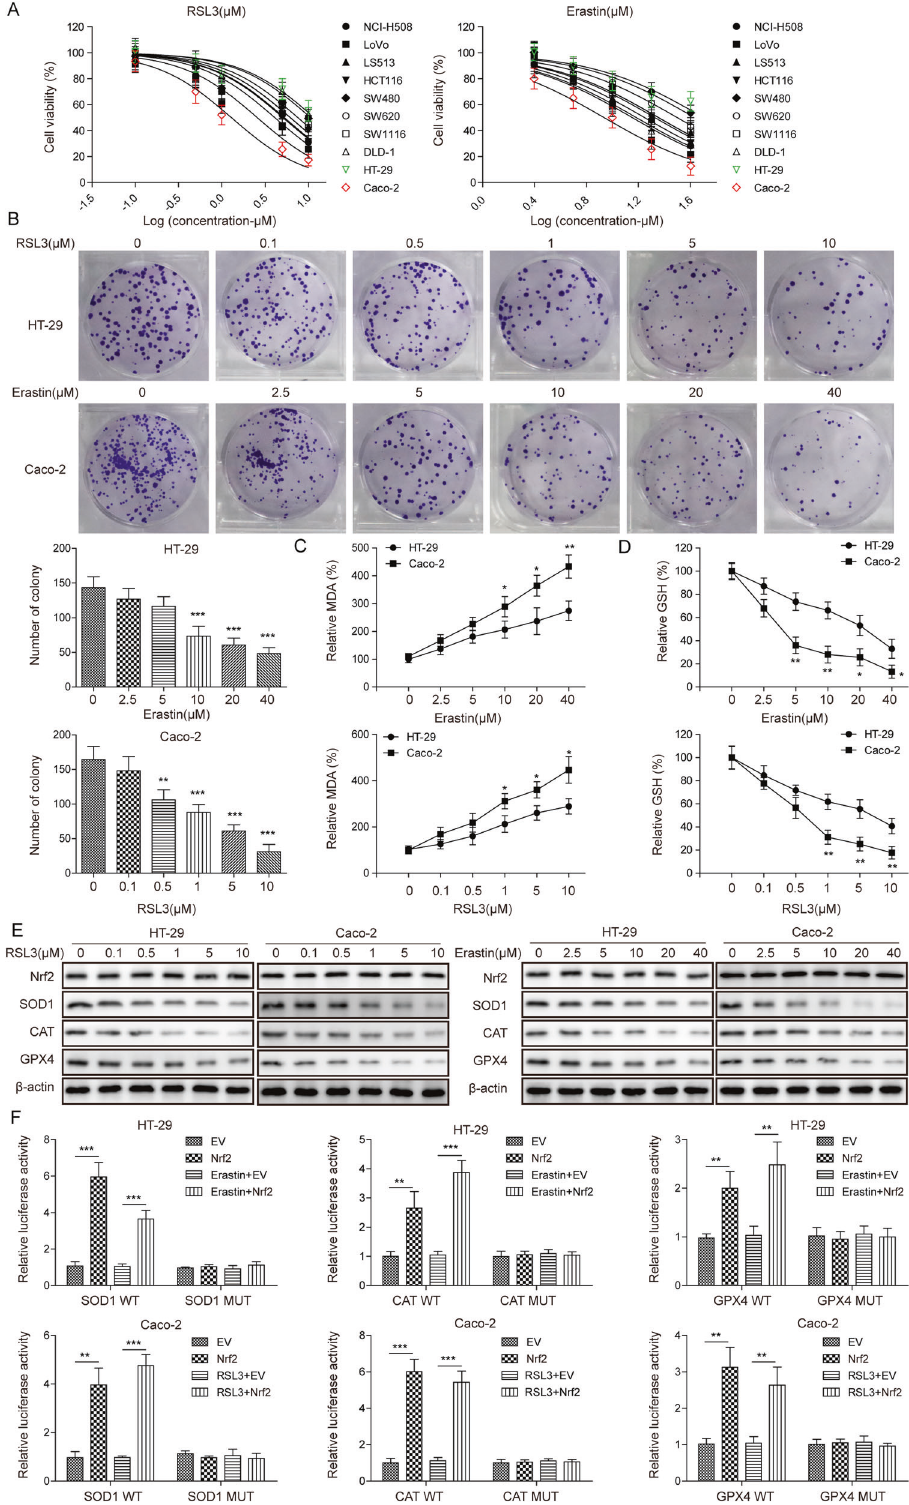
Fig. 2 RSL3 and Erastin induces CRC ferroptosis. NCI-H508, LoVo, LS513, HCT116, SW480, SW620, SW1116, DLD-1, HT-29, and Caco-2, CRC cell lines, were stimulated with serial concentrations of RSL3 (0, 0.1, 1, 5, or 10 μ M) for 48 h or were stimulated with Erastin (0, 2.5, 5, 10, 20, or 40 μ M) for 48 h. The cell A viability and B proliferation were assessed via the CCK-8 assay and the colony formation assay. The C MDA, D GSH and E Nrf2, SOD1, CAT, and GPX4 levels were detected in HT-29 and Caco-2 cells that were treated with serial concentrations of RSL3 or Erastin. F The luciferase activity of HT-29 cells that were treated with or without Erastin or Caco-2 cells that treated with or without RSL3 were co-transfected with GPX4-WT, SOD1-WT or CAT-WT or GPX4-MUT, SOD1-MUT, or CAT-MUT and Nrf2. All experiments were carried out at least three times, n = 3, * P < 0.05, ** P < 0.01 and *** P < 0.001.